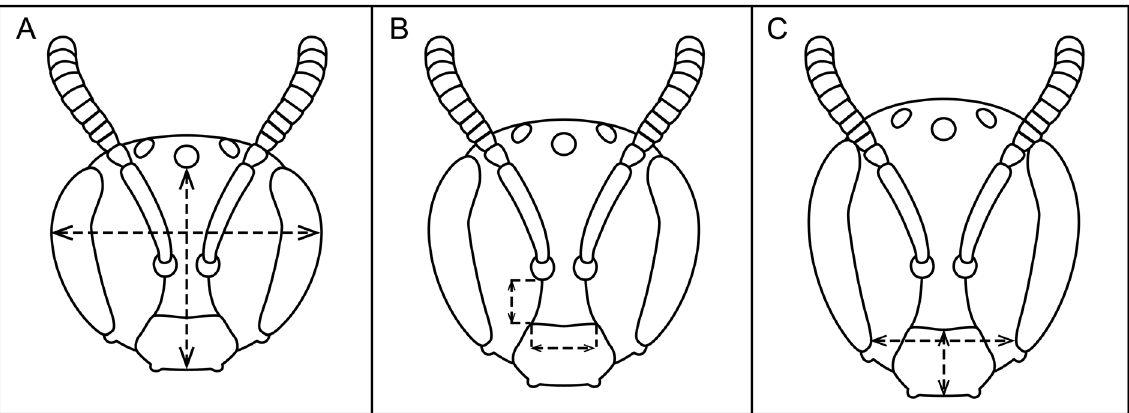
Fig. 4. Head morphometric measurements and examples of variation in face length/width ratios. A . Face short (length/width ratio ~0.75). Dotted lines and arrows show face length and width measurements. B . Face round (length/width ratio ~0.85). Dotted lines and arrows show supraclypeal area length and width measurements. C . Face long (length/width ratio ~0.95). Dotted lines and arrows show clypeus length and lower interocular distance